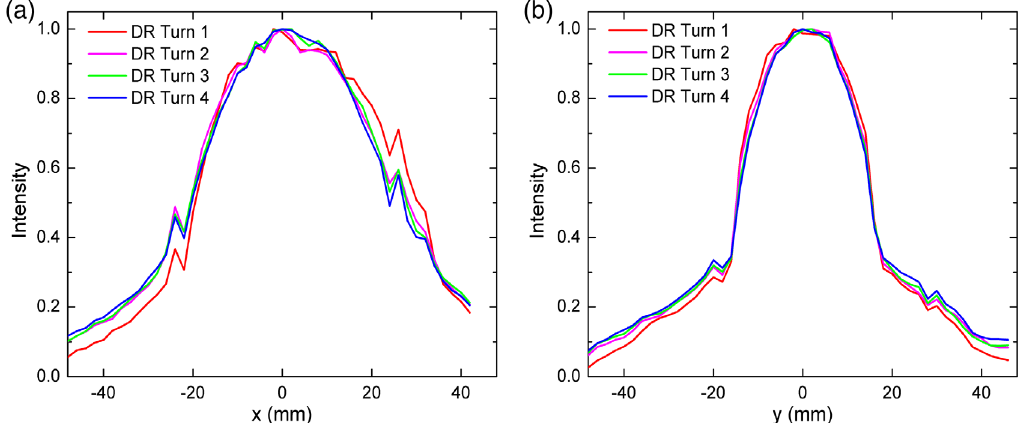
FIG. 9. Transverse beam profiles at PWC 607 for different turns along the DR of the Muon Campus. (a) Horizontal direction. (b) Vertical direction. Notice that the beam profile is reproducible from turn to turn. The kinks in the distribution are due to the discrete nature of the collected signal on the profile